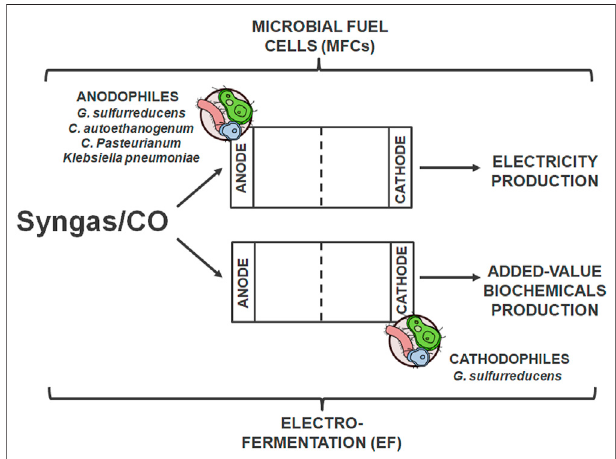
FIGURE 5 | Bioelectrochemical syngas conversion in BESs using electrochemically active bacteria (EAB) applied at the anode and cathode to produce bioenergy and biochemicals,